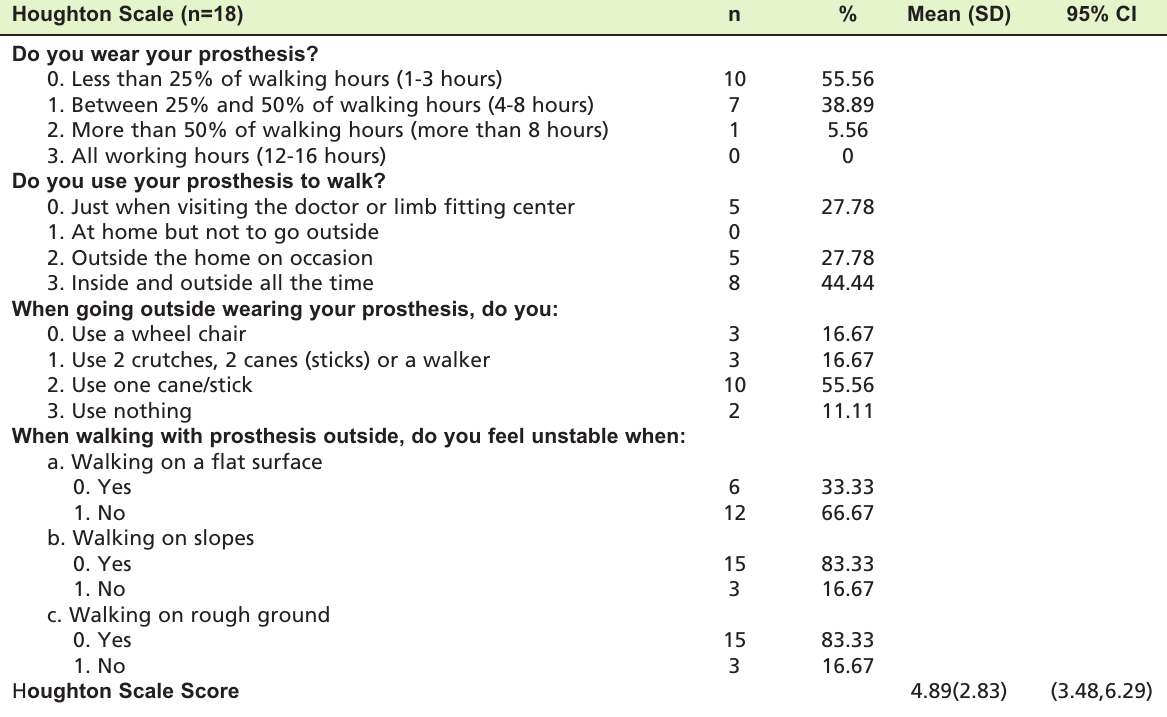
Prosthesis use in TTA with Table IV: